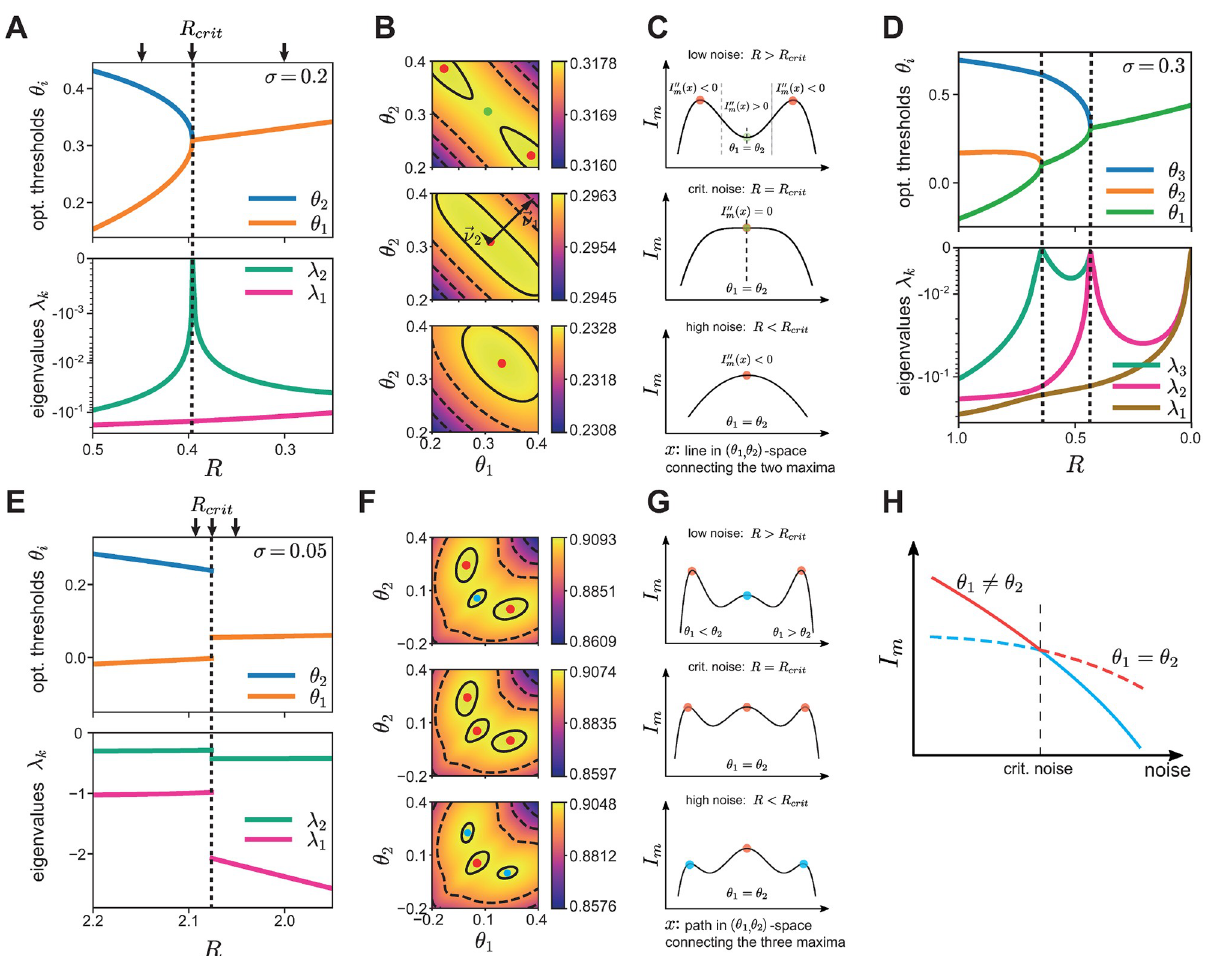
Fig 6. Information landscape for the independent- and lumped-coding channels undergoes different phase transitions around critical noise levels. A . Top: Optimal thresholds of the independent-coding channel for a population of two neurons as a function of output noise R . Bottom: Corresponding eigenvalues of the Hessian of the information landscape with respect to thresholds. At the critical noise value R crit � 0.396 at which the threshold bifurcation occurs (vertical dashed line) one eigenvalue approaches zero. B . Information landscape I m ( θ 1 , θ 2 ) for the three output noise levels R indicated by arrows in A. Top: For R > R crit , there are two equal global maxima. Middle: At R = R crit , the eigenvectors of the Hessian are shown and scaled by the corresponding eigenvalue (the eigenvector with the smaller eigenvalue, ~ v , was artificially lengthened to show its direction). At the critical 2 noise value the information landscape locally takes the form of a ridge. Bottom: For R < R crit , there is one global maximum, meaning that the optimal thresholds are equal (bottom). C . The mutual information as a function of the line x in ( θ 1 , θ 2 ) space connecting the two maxima in B. Top: For R > R crit (low noise), there are two inflection points (dashed vertical lines) with zero curvature along the line x . The point with equal thresholds corresponds to a local minimum. Middle: At R = R crit , the two maxima, the minimum, and the two inflection points merge into one point, thus the curvature is zero. Bottom: For R < R crit , there is a single global maximum with a negative curvature. D . As in A but for a population with N = 3 neurons. E . As in A but for the lumped-coding channel. Both the optimal thresholds and the eigenvalues show a discontinuity at the critical noise level. F . Information landscape as in B for the lumped-coding channel and noise values indicated by arrows in E. Local optima are shown in cyan, global ones in red. G . Similar to C for the lumped-coding channel. Here the abscissa denotes the (non-straight) path connecting the three optima in F. H . Illustration of discontinuous threshold bifurcations, where the global maximum at θ 1 6¼ θ 2 at low noise (red, solid) becomes a local maximum for high noise (cyan, solid), while θ 1 = θ 2 (dashed) becomes global. As their respective derivatives are different, there is a discontinuity in the first derivative when only taking the global maximum into account (red lines), corresponding to a first-order phase transition.